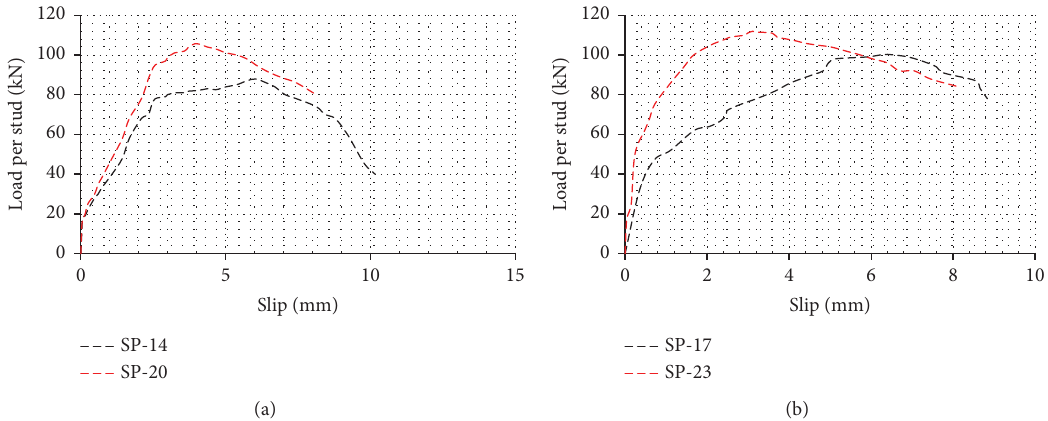
Figure 11: Effect of change in diameter of the connector on the capacity of shear connection with reentrant profiled steel sheeting [(a) d � 19mm and (b) d �